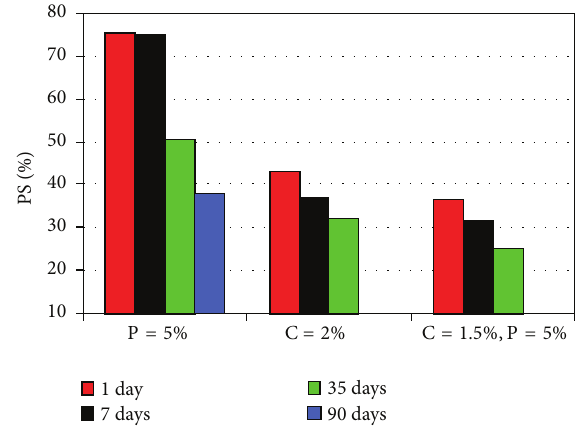
Figure 7: Comparison of results from chemical tests.